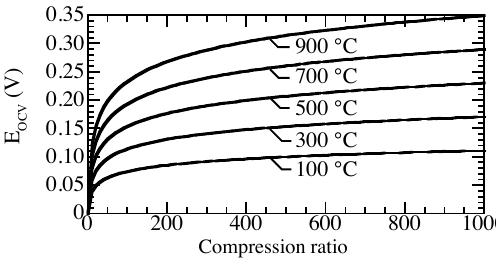
Figure 8. Open-circuit voltage, compressing from 1 bar across a proton-conducting membrane for pressure ratios between 1 and 1000, and temperatures between 100 ◦ C and 900 ◦